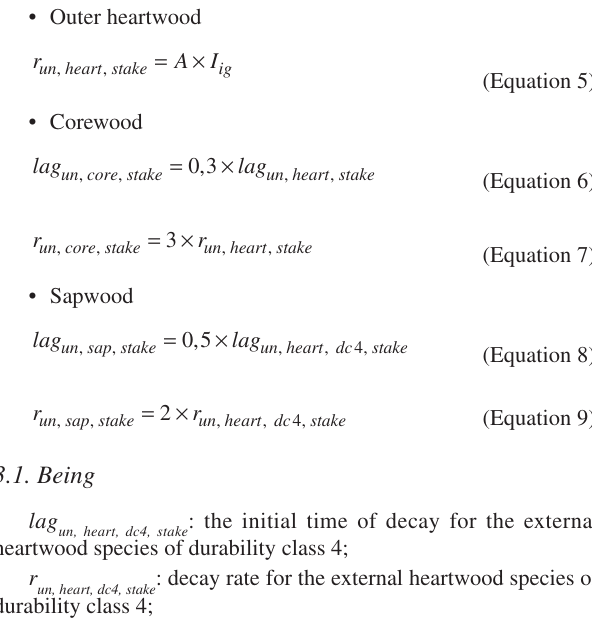
Figure 2. Relationship of idealized decay 9 .